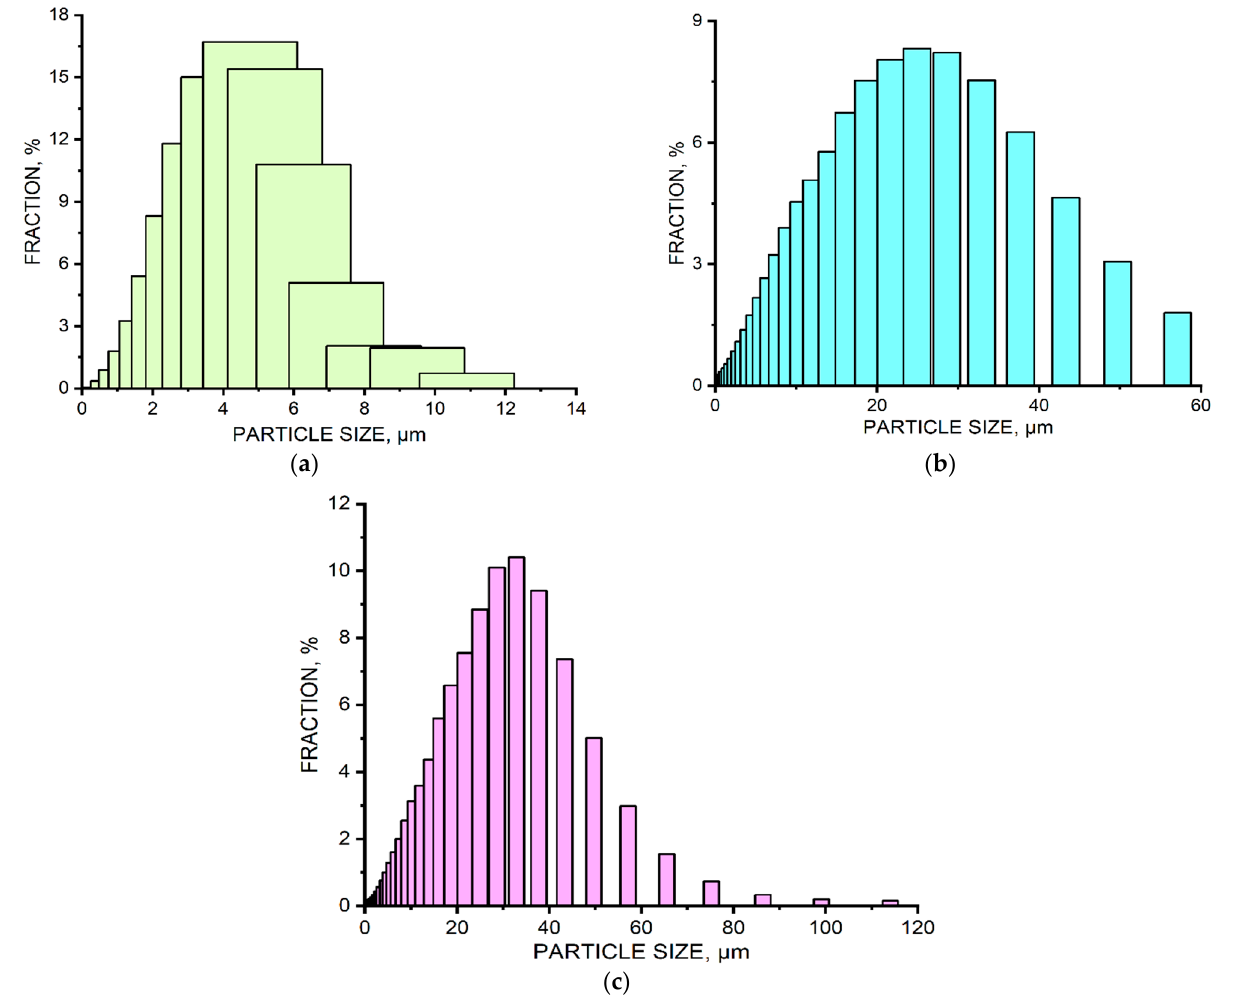
Figure 3. Particle size distribution of initial commercial powders: ( a ) ASP-5, ( b ) ASP-22, and ( c ) ASP-30. During electrostatic separation, ASP-22 and ASP-5 powders (D50 = 21.9 μ m and D50 = 4.9 μ m, respectively) showed poor processability. These powders tend to agglomerate,